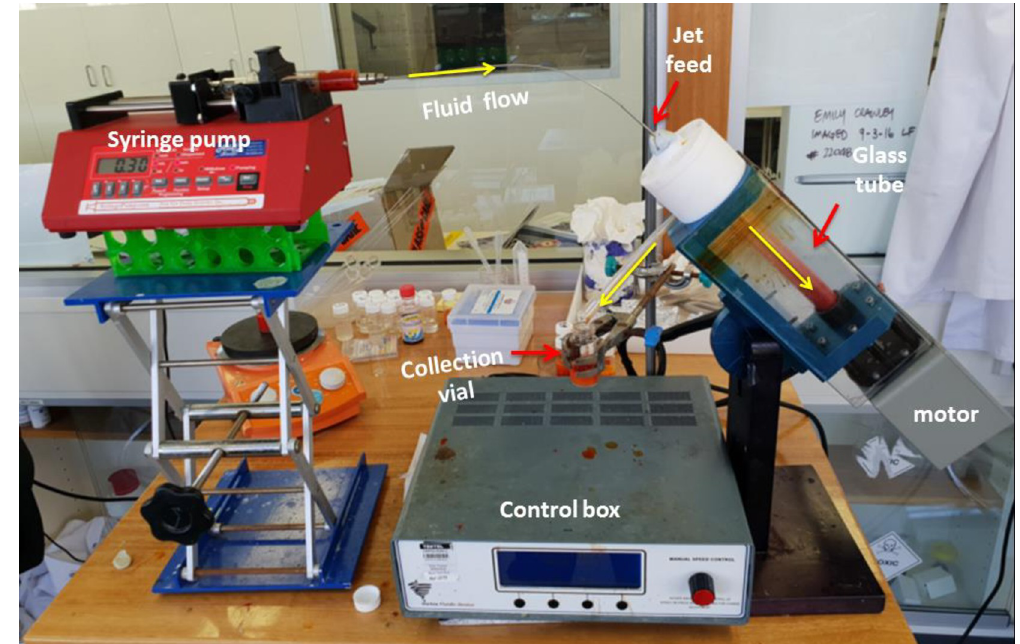
Fig 1. Photograph of the vortex fluidic device (VFD) highlighting its salient